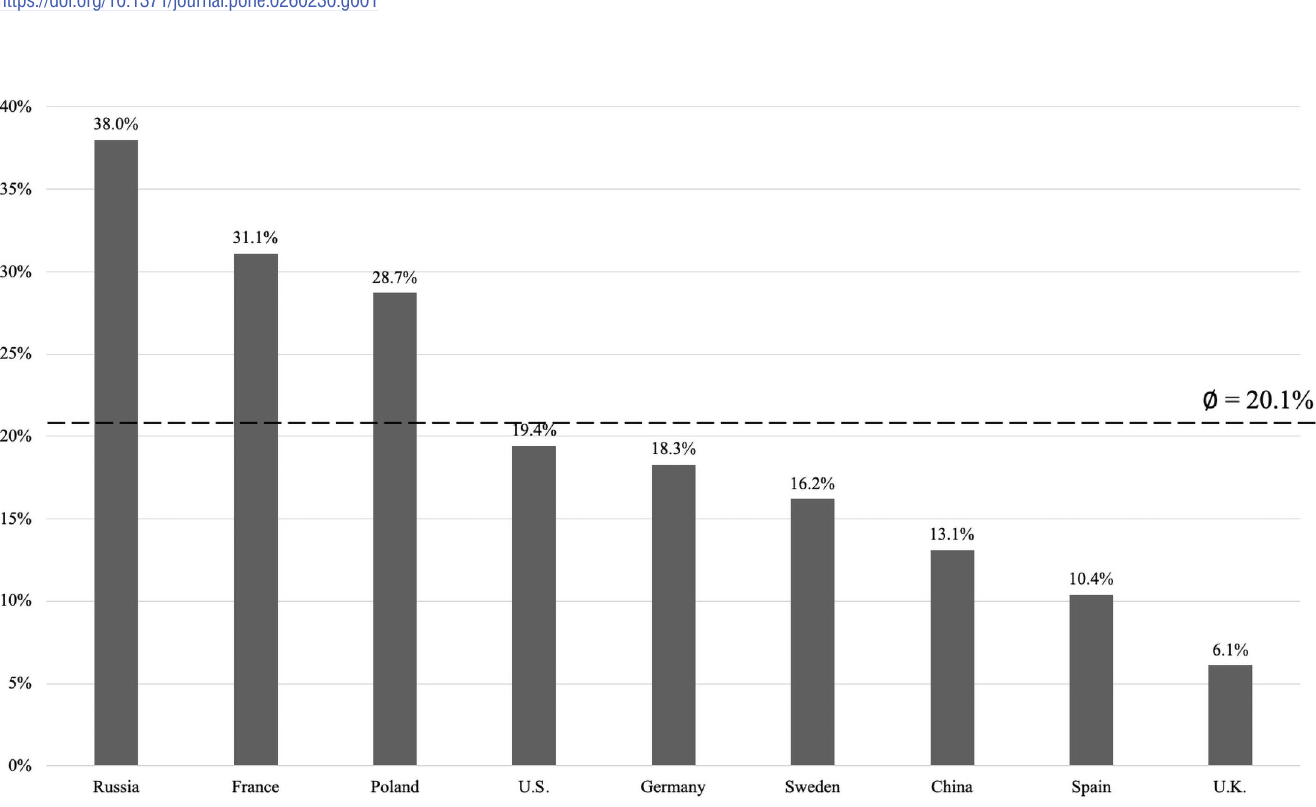
Fig 2. Percentage of participants who do not want to be Covid-19 vaccinated (country-specific samples). Notes. China: N = 1,020, France: N = 1,001, Germany: N = 1,145, Poland: N = 1,004, Russia: N = 1,024, Spain: N = 985, Sweden: N = 1,003, the U.K.: N = 1,050, the U.S.: N = 1,032. Overall vaccination rejection = 20.1%.